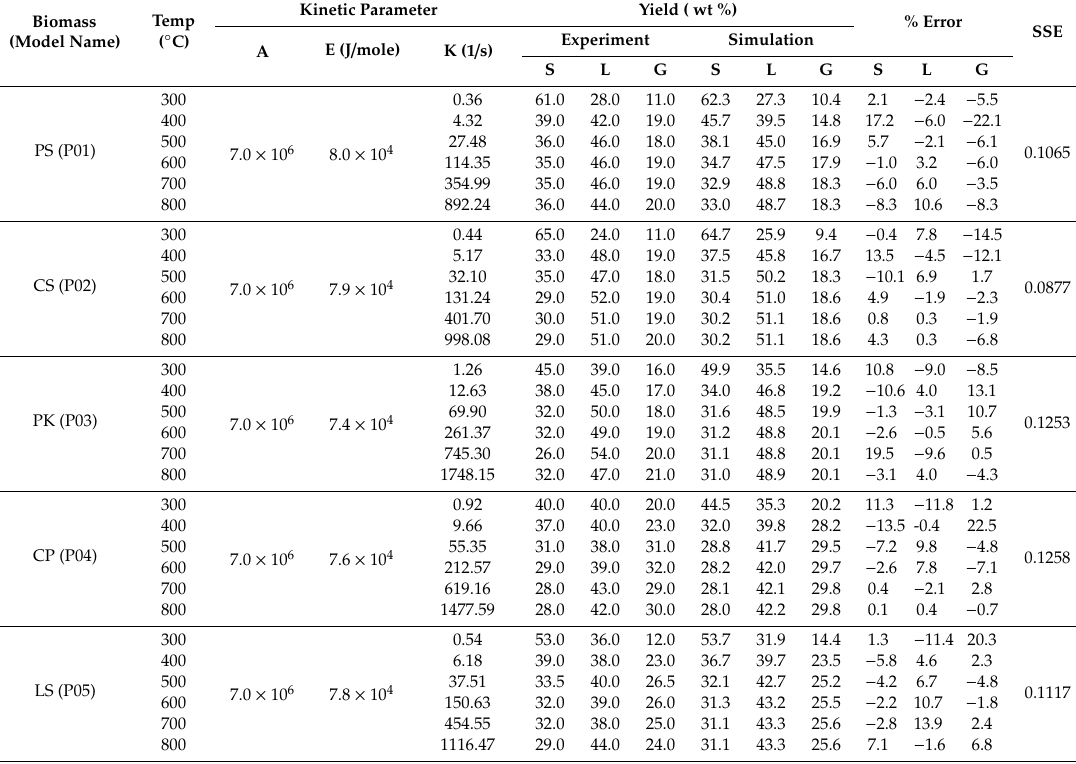
Table 3. Optimum values of kinetic parameters and the comparison of experimental and simulated product yields of solid (S), liquid (L), and gas (G) using models P01(PS), P02(CS), P03(PK), P04(CP), and